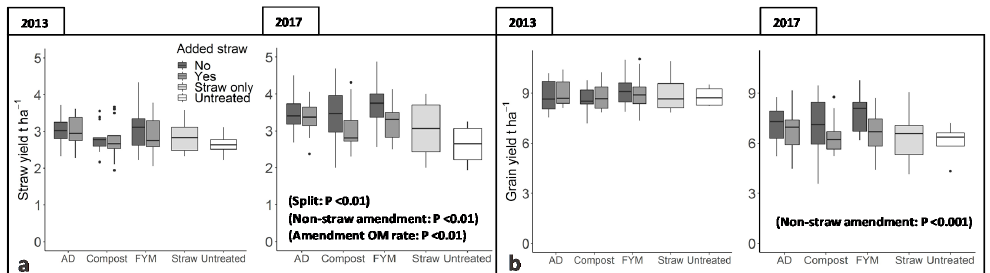
Figure 1. Median ( ± 25th and 75th quartiles, 95% CI and outliers) of ( a ) straw yield and ( b ) grain yield in the baseline year 2013 and in 2017. Wheat (and barley in 2013) was grown on plots treated with di ff erent organic matter amendments or without amendment. The amended plots also had additional straw or not (Yes and No, respectively). All plots had received the same rate of inorganic fertilizer. Per treatment the results are pooled from plots receiving di ff erent OM rates; 1–4 ( n = 4 of each, total n =